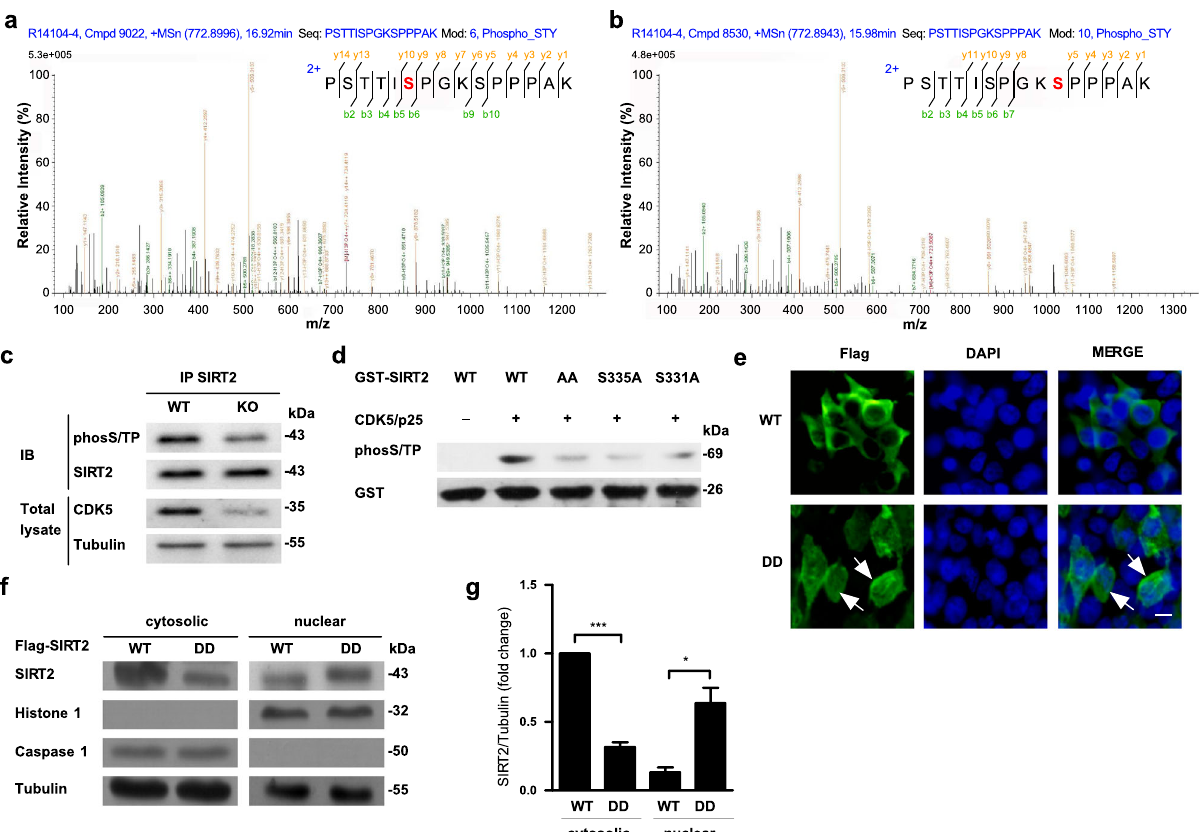
Fig. 6 Cdk5 phosphorylates SIRT2 and thereby mediates the nuclear translocation of SIRT2. a Liquid chromatography-mass spectrometry after a kinase assay in vitro demonstrated that the Ser331 and b Ser335 sites of SIRT2 were phosphorylated by Cdk5. c Phosphorylation levels of SIRT2 were detected in forebrain cortical tissue obtained from forebrain neuron-speci fi c Cdk5 knockout mice and WT mice. Phosphorylation of SIRT2 was detected in primary culture neurons using immunoprecipation and western blotting with anti-phosS/TP and anti-SIRT2 antibodies. d SDS-PAGE used for the Cdk5/p35 kinase assay in vitro. Puri fi ed GST-SIRT2 WT, S331A, S335A, and S331AS335A (AA) fusion proteins were mixed with active Cdk5/p35 and ATP, and the reaction mixture was analyzed using western blotting with anti-phosS/TP and anti-GST antibodies. e HEK293 cells were transiently transfected with Flag-SIRT2 WT or Flag-SIRT2 mutation DD (double mutations at S331D and S335D) plasmids for 24 h, and subsequently, the cytoplasmic and nuclear distribution of SIRT2 (green) was detected using immuno fl uorescence staining. The scale bar represents 10 μ m. f Immunoblotting assays for SIRT2 was performed using an anti-Flag antibody in HEK293 cells transfected with Flag-SIRT2 WT or Flag-SIRT2-DD. g Quanti fi cation of SIRT2 protein levels shown in f ( n = 3). All data are presented as the means ± SD. Statistical analyses were conducted using two-way ANOVA followed by Tukey ’ s post hoc test in g . * P < 0.05, *** P <